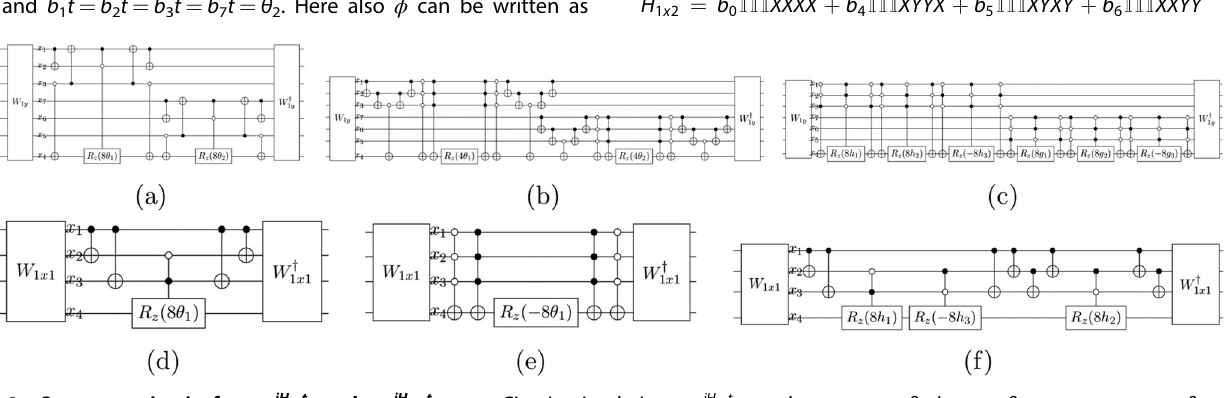
Fig. 2 Quantum circuit for e (cid:1) iH 1 y t and e (cid:1) iH 1 x 1 t . a – c : Circuit simulating e (cid:2) iH 1 y t a when a 6 t = − θ 1 , b 1 t = − θ 2 , a 3 t = a 5 t = a 7 t = θ 1 and b 2 t = b 3 t = b 7 t = θ 2 ; b when a 0 t = … = a 7 t = θ 1 and b 0 t = … = b 7 t = θ 2 ; c when the coef fi cients are as in Equation 18. d – f : Circuit simulating e (cid:2) iH 1 x 1 t d when